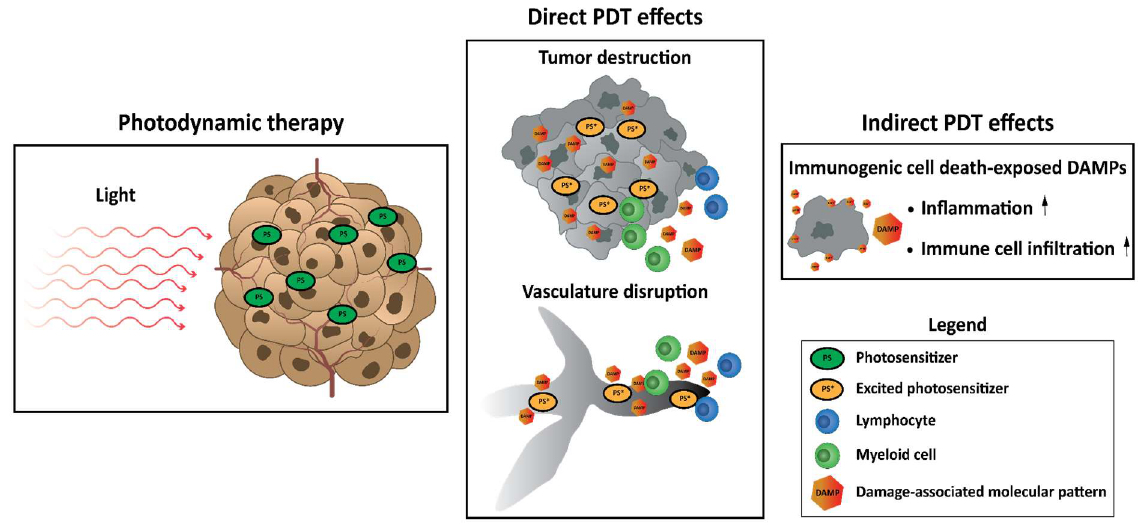
Figure 3. Consequences of photodynamic therapy.